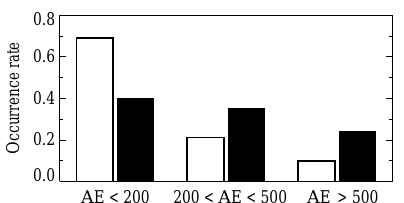
Figure 9. Histograms of the percentage of time that multiple satel- lites are in the plasma sheet (left bar) and DF events (right bar) when AE < 200nT, 200 < AE < 500nT, and AE > 500nT; if at least two satellites are simultaneously in the plasma sheet, we count the time just once.